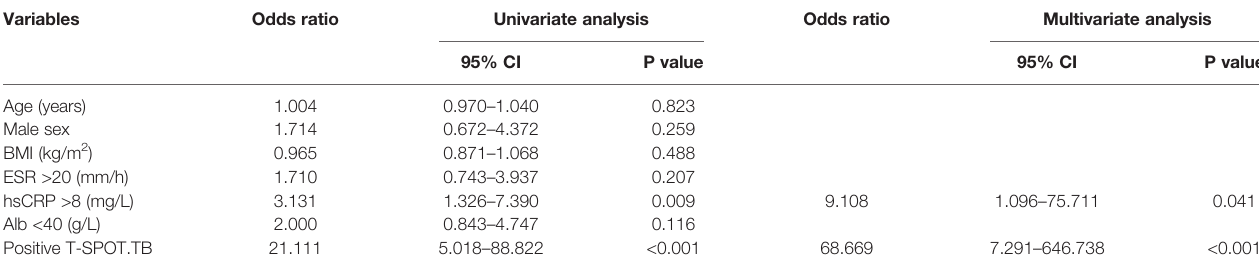
TABLE 3 | Univariate and multivariate analyses of the correlation between clinical variables and the development of ATB in TAK patients. Variables Odds ratio Univariate analysis Odds